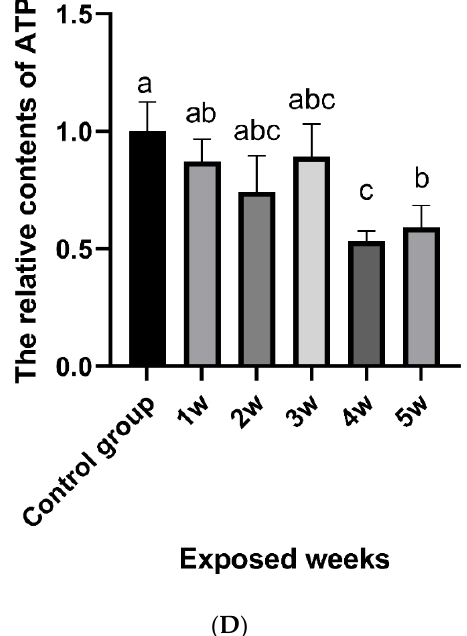
Figure 4. Time series of mitochondrial damage. ( A ) Mitophagy protein; ( B ) Mitophagy regulatory proteins; ( C ) Mitochondrial fission and fusion proteins; ( D ) ATP. The data are expressed as the mean ± SD (n = 8) and analyzed by ANOVA following the Turkey’s multiple comparisons test. Note: Lowercase letters are completely different, indicating significant difference ( p < 0.05); any of the same lowercase letters means insignificant difference ( p > 0.05).